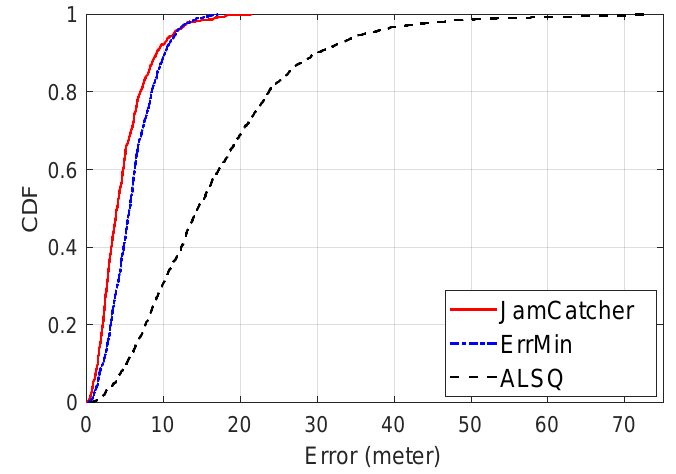
Figure 9. CDF of the localization errors of JamCatcher , ErrMin, and ALSQ .